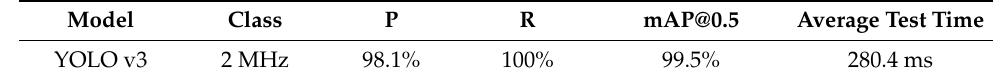
Table 1. Summary of YOLO v3 test result. P, precision; R, recall; mAP, mean average precision.